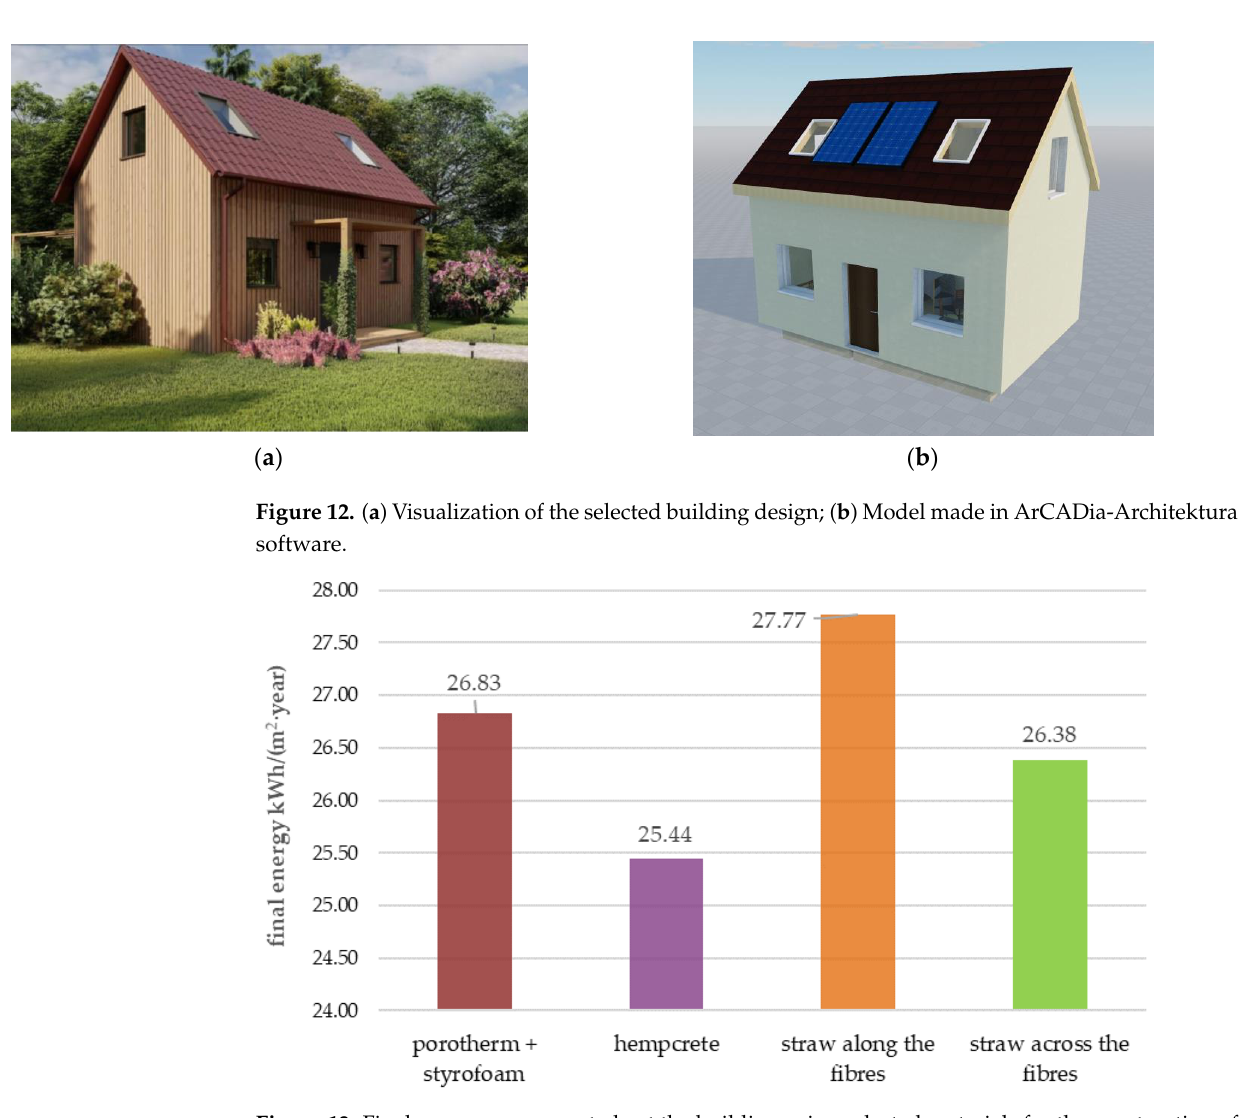
Figure 13. Final energy necessary to heat the building using selected materials for the construction of external walls.